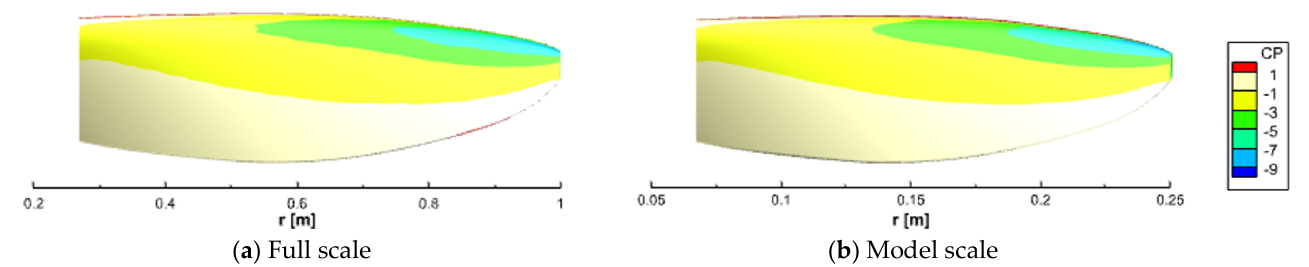
Figure 16. Comparison of the blade surface pressure distribution (suction side) at J = 1.20; pitch angle = 34°.